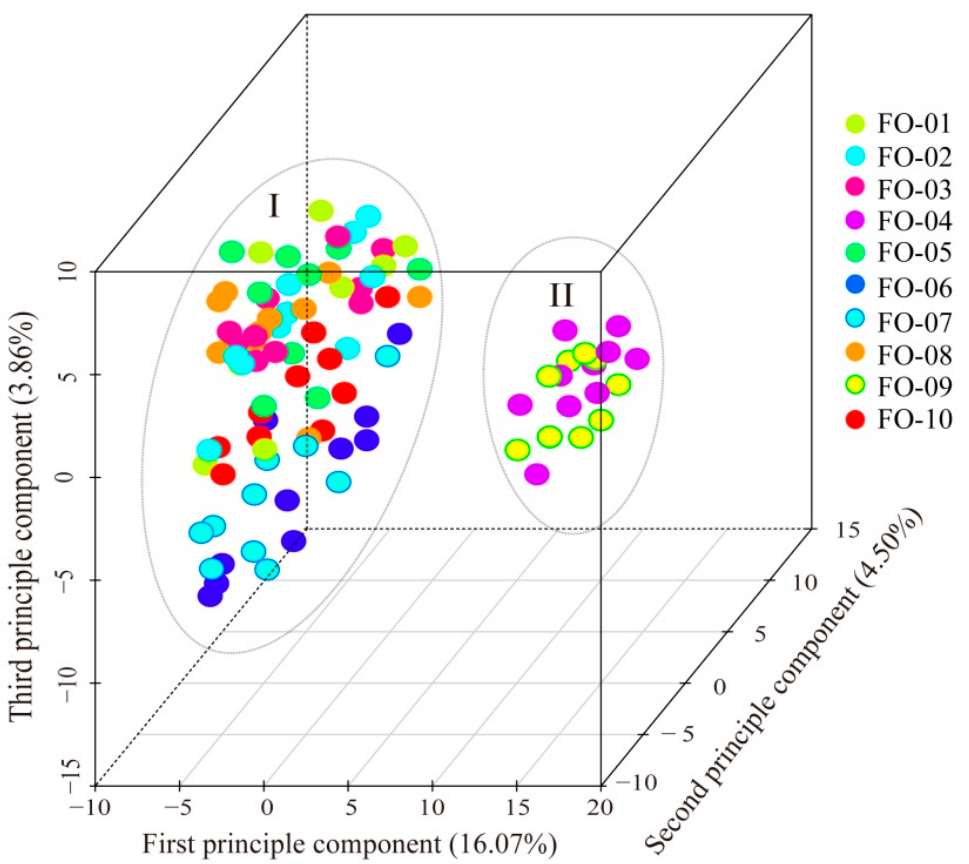
Figure 2. Principal coordinates analysis (PCoA) of 100 F. ovina individuals from 10 populations based on genetic distance matrix. The 10 individuals of per population were represented by the same dots.